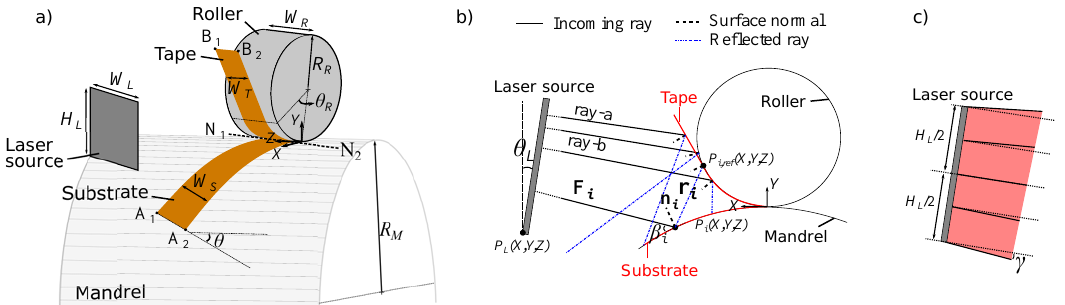
Figure 2. ( a ) Geometry of the parametric 3D optical model. ( b ) Schematic of ray-tracing approach with incoming ray and reflection for tape (ray-a), substrate ( F i ) and roller (ray-b). ( c ) Schematic of the laser divergence angle γ which is maximum at the edges and linearly decreases to 0 ◦ at the center of laser